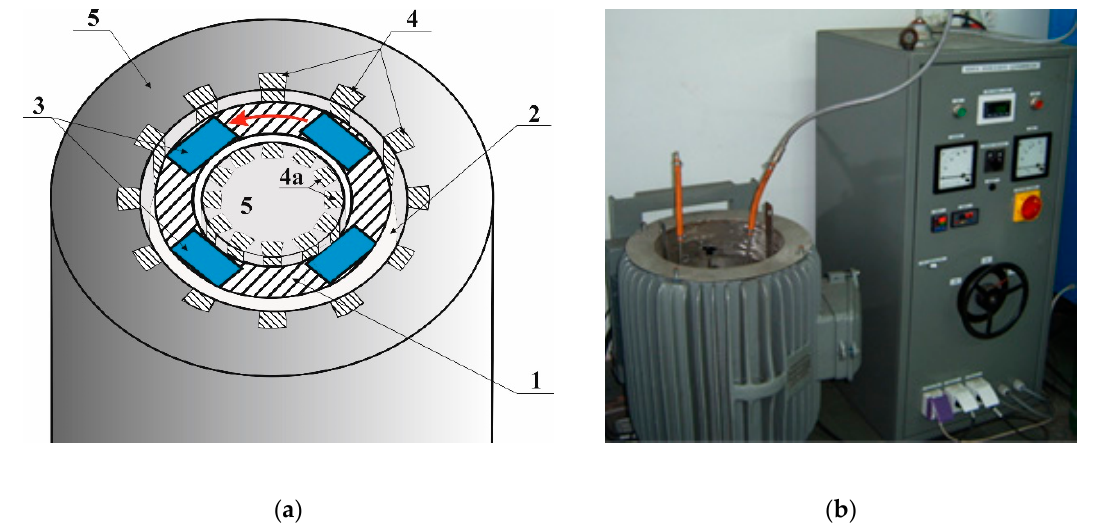
Figure 2. ( a ) Scheme of the collector metal method with mhd pump: 1—metal, 2—air, 3—auto catalysts, 4—winding, 4a—internal inductor, 5—magnetic core; ( b ) View of the prototype device.